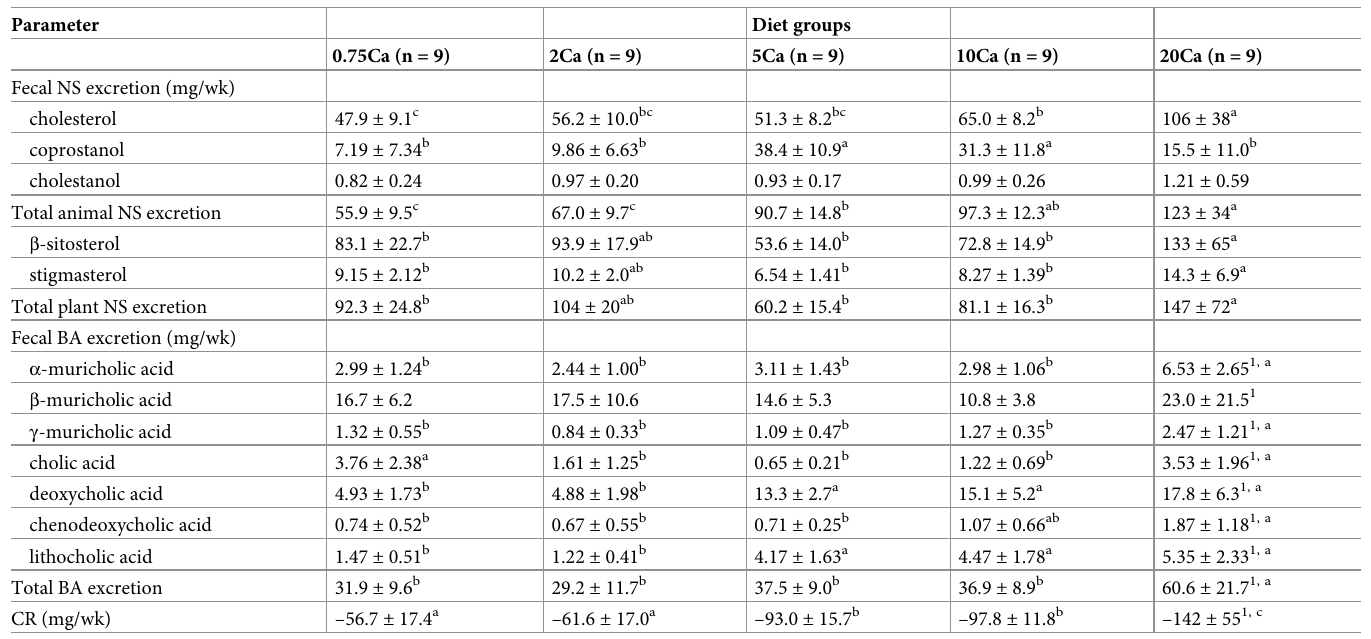
Table 5. Fecal excretion of neutral sterols and bile acids during week 8 of the